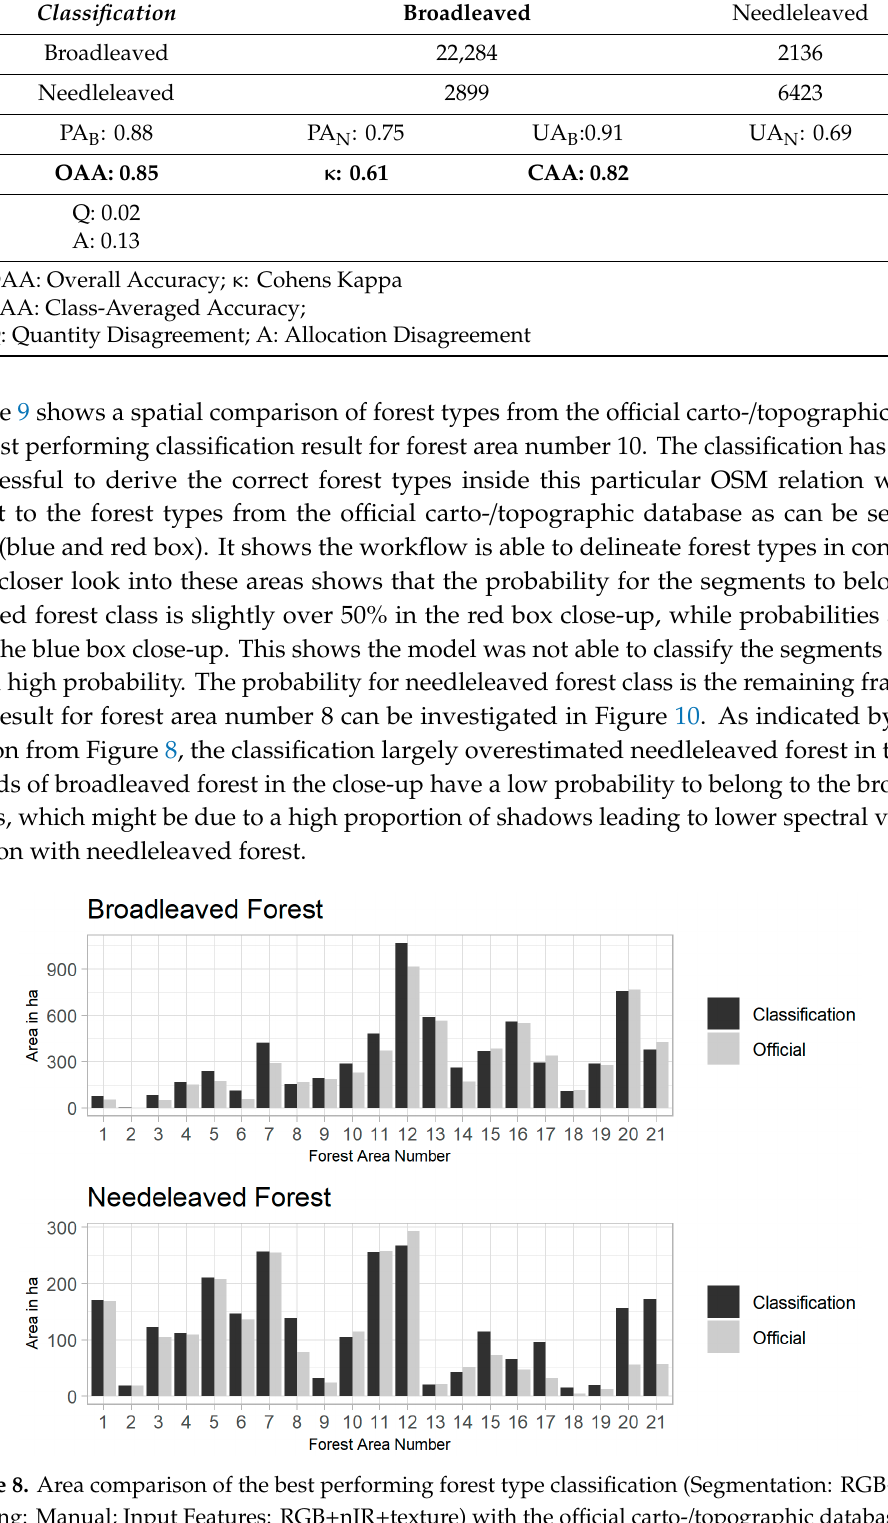
Figure 9. Comparison of forest types from the official carto-/topographic database with the best performing forest type classification for forest number 10 (Segmentation: RGB+nIR; Training: Manual; Input Features: RGB+nIR+texture) with close-ups to areas where stratification has been successful. Values indicate probability of the area to belong to broadleaved forest type class as derived from the randomForest model.